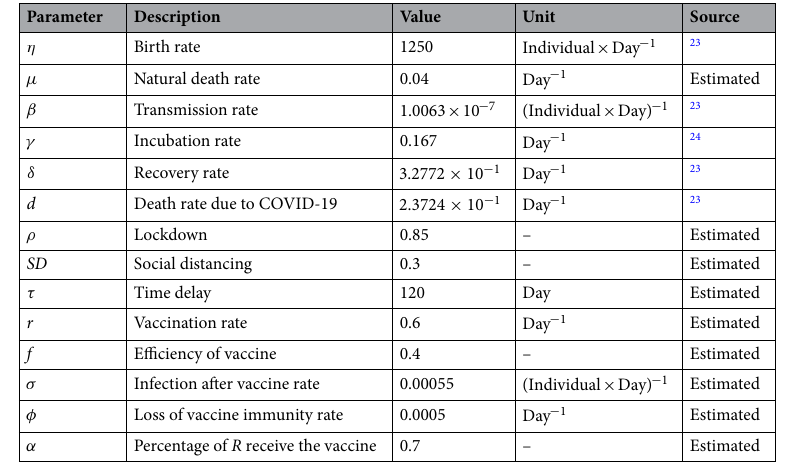
Table 1. The description and values of the parameters in model